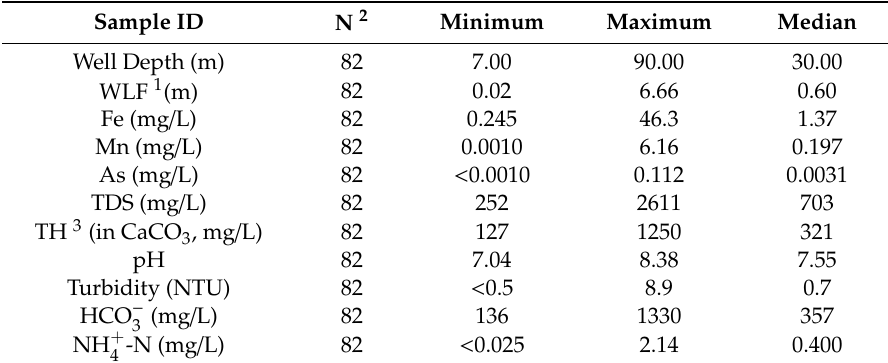
Table 1. Summary of physio-chemical and field measurements.